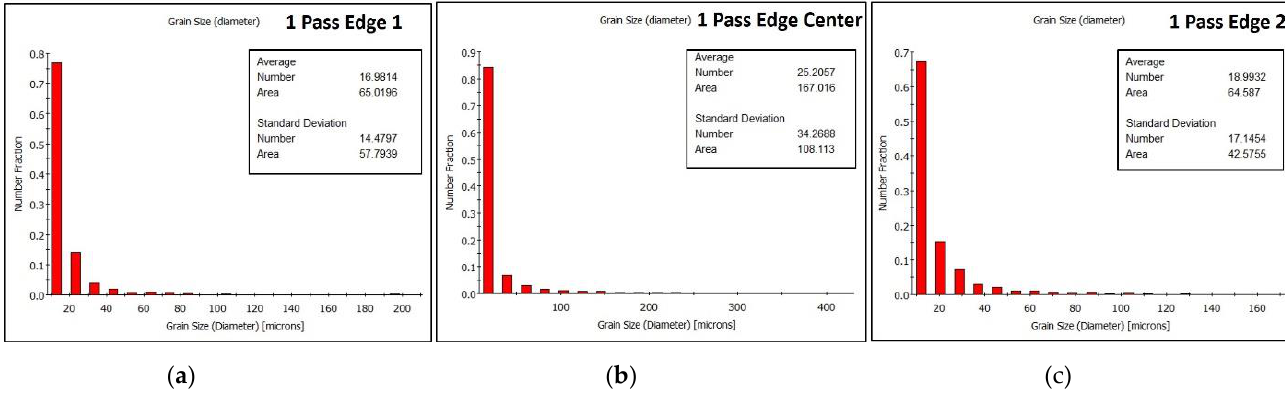
Figure 15. Grain size distribution across the 1 pass ECAP processed AA2011 calculated from the EBSD data presented in Figure 10 ( a ) left edge, ( b ) center, ( c ) right edge.